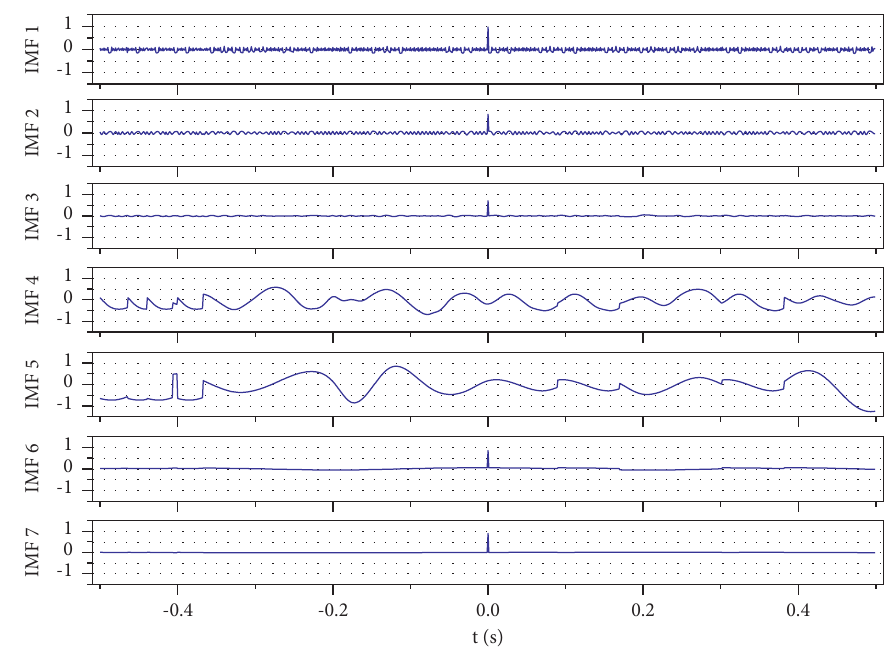
Figure 7: ACF of each IMF by